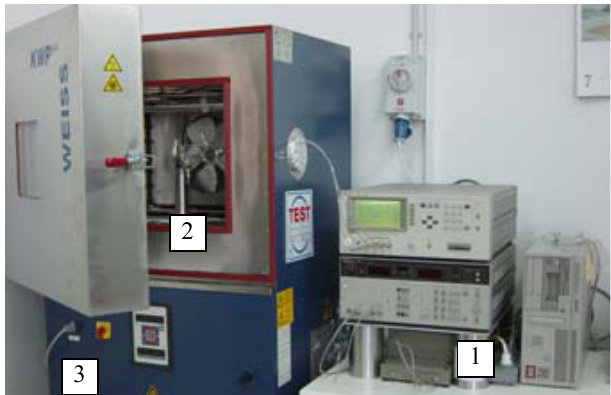
Figure 4. The experimental setup used for measuring multi-frequency temperature dependent complex permittivity values of highly insulating transformer oils: (1) high precision LCR unit, (2) the coaxial cylindrical test fixture, and (3) temperature controlled environmental chamber. All units were computer